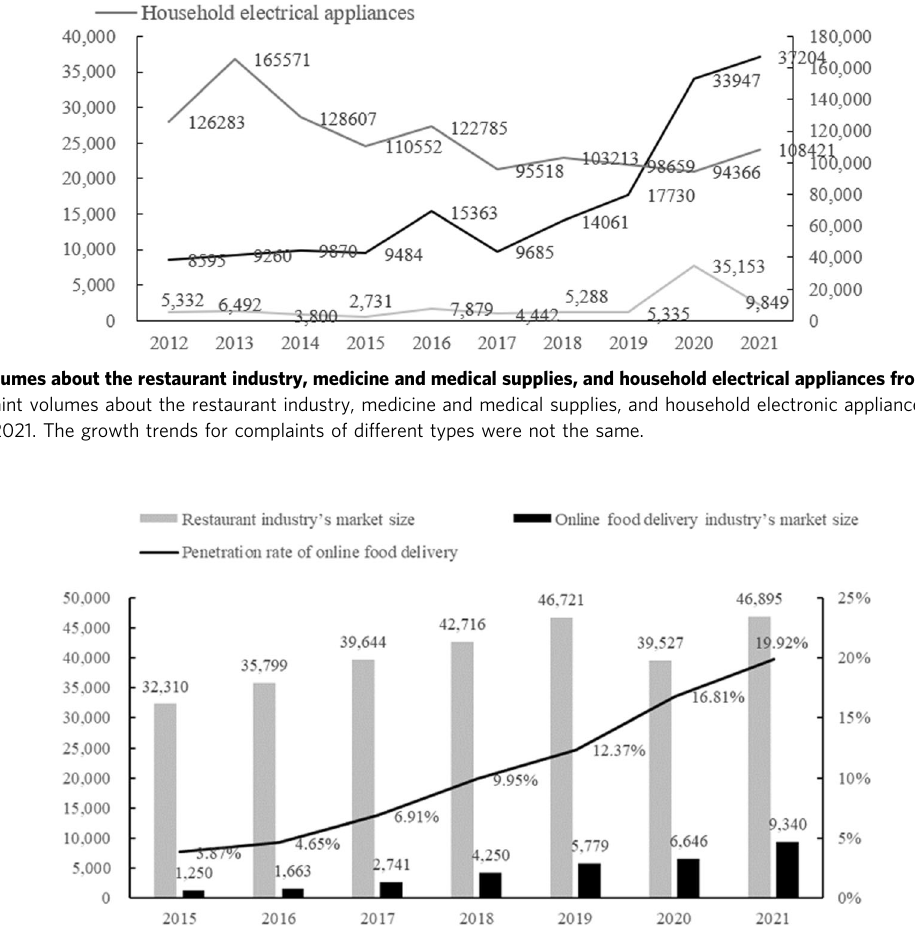
Fig. 3 Market size of restaurant industry, and market size and penetration rate of online food delivery industry in China from 2015 to 2021 (100 million yuan, %). The gray and black columns show the restaurant industry ’ s market size and online food delivery industry ’ s market size, respectively. The line shows the penetration rate of online food delivery in China from 2015 to 2021. Source: National Bureau of Statistics of China. (2022). Annual data report of the restaurant industry. http://www.stats.gov.cn/ China Hotel Association, Ali New Service Research Center, Ele.me Training and Learning Center and Keruyun (2022). 2020 – 2021 Research Report on Food Delivery Industry Development in China.